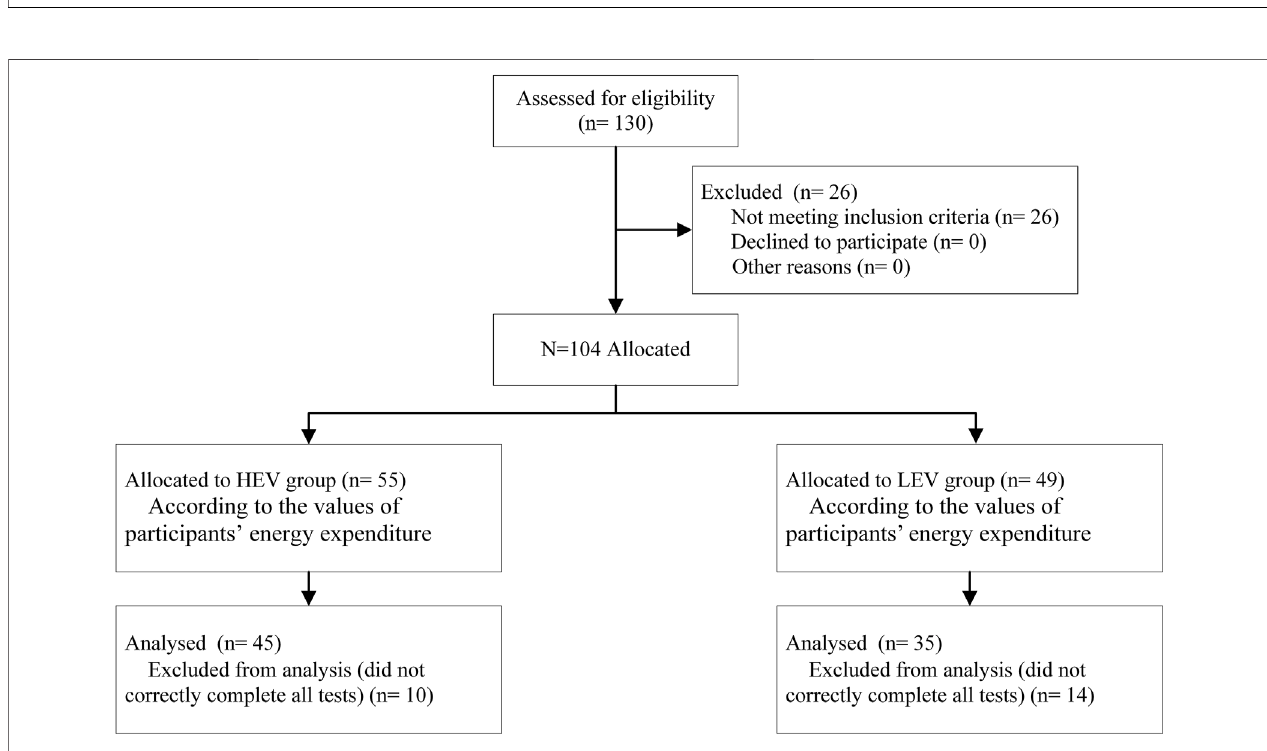
FIGURE 1 | (A) Division of the foot. (B) Results of tissue hardness of plantar tissue in participants (Mean with SEM). The tissue hardness of the little toes was the averageofarea8andarea9;thetissuehardnessoftheforefootwastheaverageofarea5,area6andarea7;thetissuehardnessofthemidfootwastheaverageofarea3 and area 4; the tissue hardness of the hindfoot was the average of area 1 and area 2. HEV: High Exercise Volume ( ≥ 27 Mets · h/week); LEV: Low Exercise Volume ( < 27 Mets · h/week); SEM: standard error of mean. * indicates a signi fi cant difference between the HEV group ( n (cid:2) 45) and LEV group ( n (cid:2) 35) ( p < 0.05).